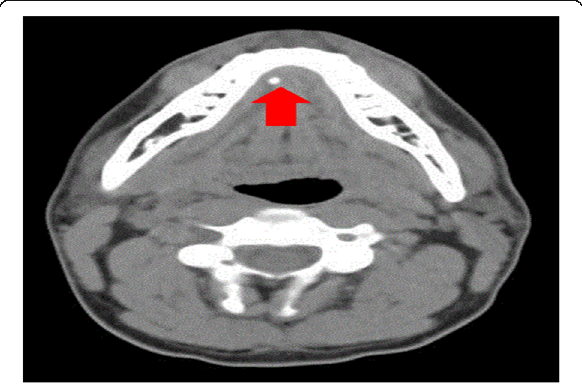
Fig. 1 CT scan neck axial view without contrast showing a 2-mm right submandibular gland stone that was not detected by U/S (red arrow)